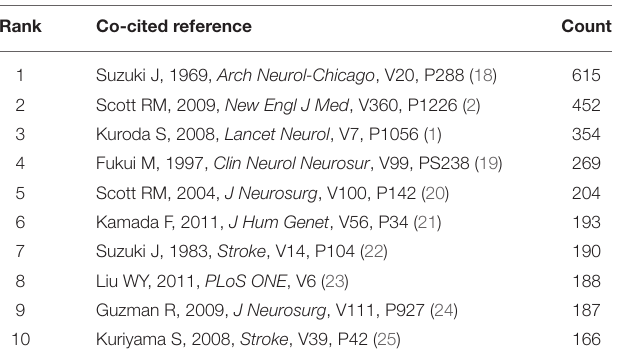
TABLE 6 | The top 10 co-cited reference with regard to MMA during 2010–2019.